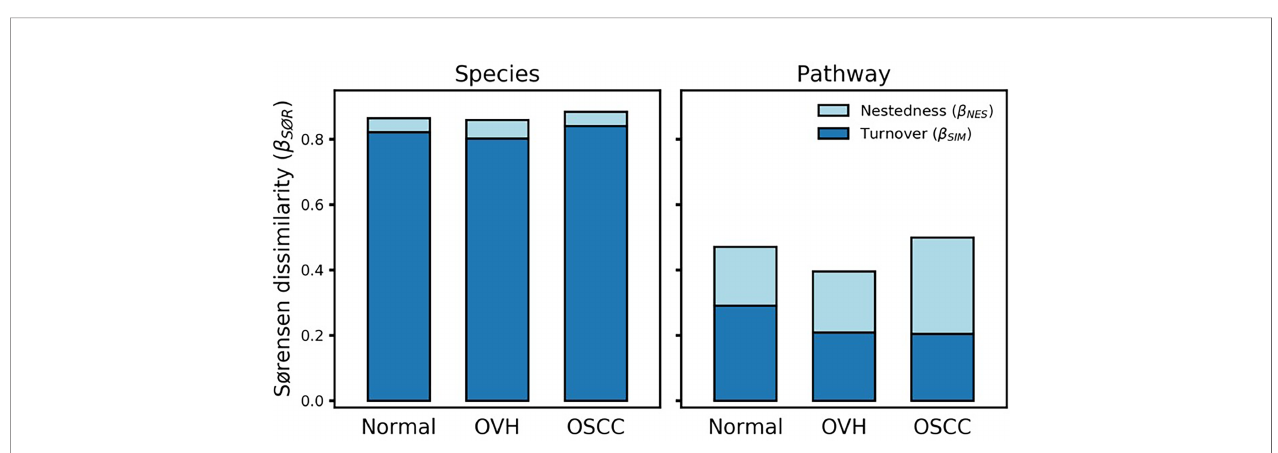
FIGURE 4 | Multiple-site beta diversity (Sørensen dissimilarity) and corresponding nestedness and turnover components. The dissimilarities were analyzed in terms of species and metabolic pathway pro fi les in each